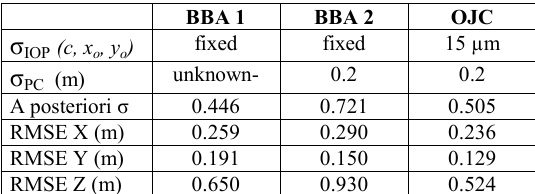
Table 9. Results for aerial images of band 23 with IOPs of band 23 from terrestrial calibration: a posteriori sigma and RMSE in the check points coordinates.